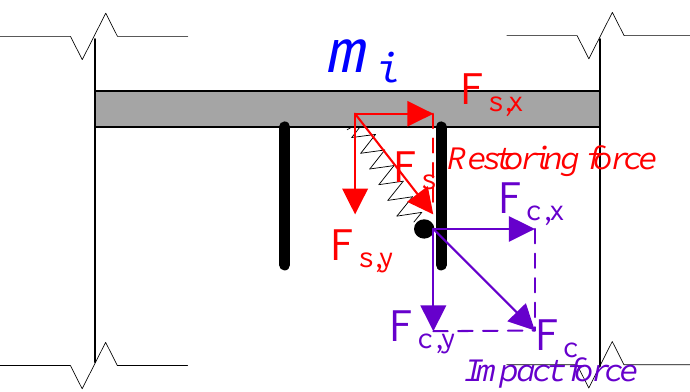
Figure 7. Controlling forces imposed on the i th degree of freedom (DOF).